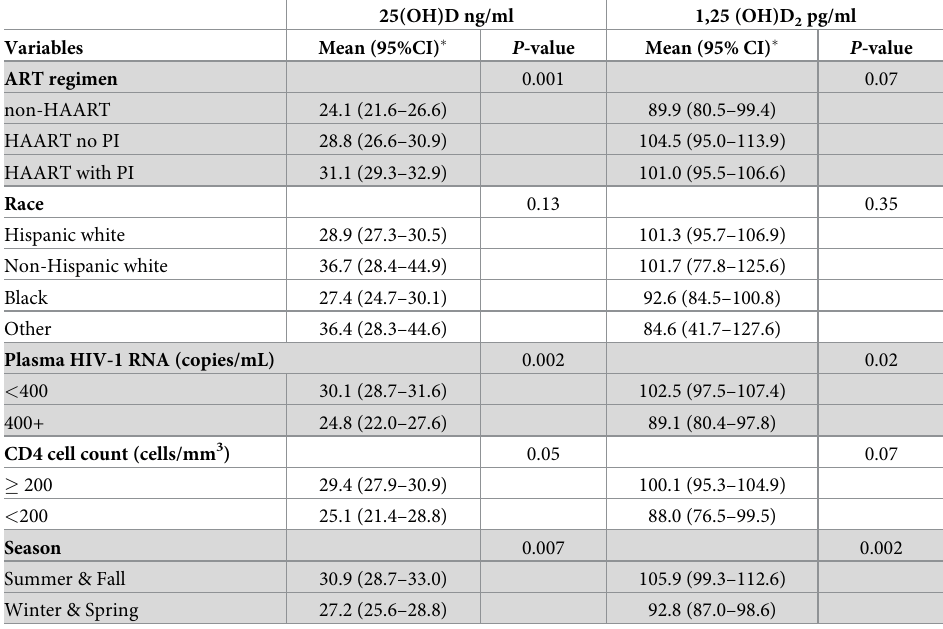
Table 2. Factors univariately associated with vitamin D